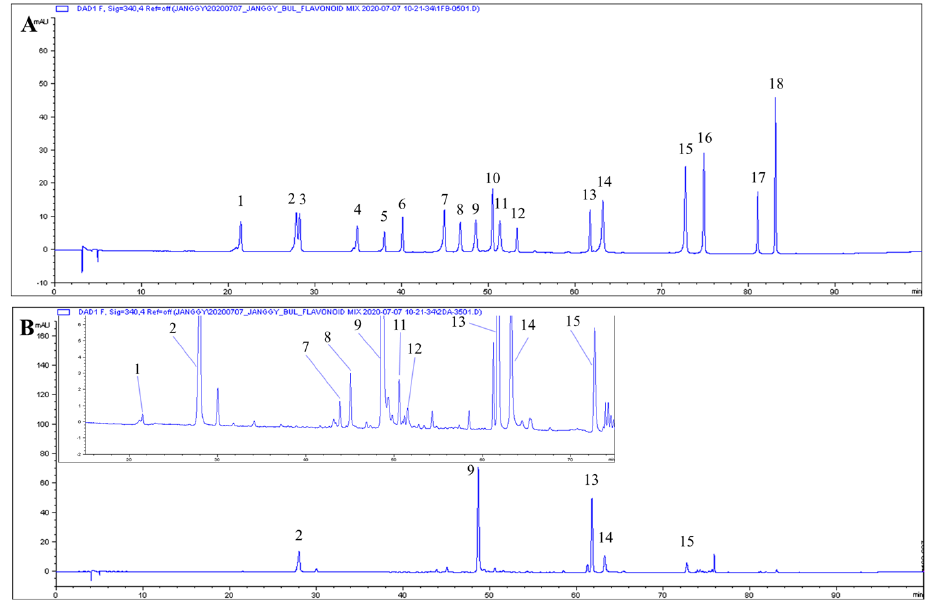
Figure 7. Typical chromatogram of extract of Chrysanthemum boreale (Makino) Makino (CB) flower. Samples: ( A ), standard mixture; ( B ), extract from CB. Standards: 1, neochlorogenic acid; 2, chloro- genic acid; 3, 4- O -caffeoylquinic acid; 4, 1,3-di- O -caffeoylquinic acid; 5, vicenin-1, 6,